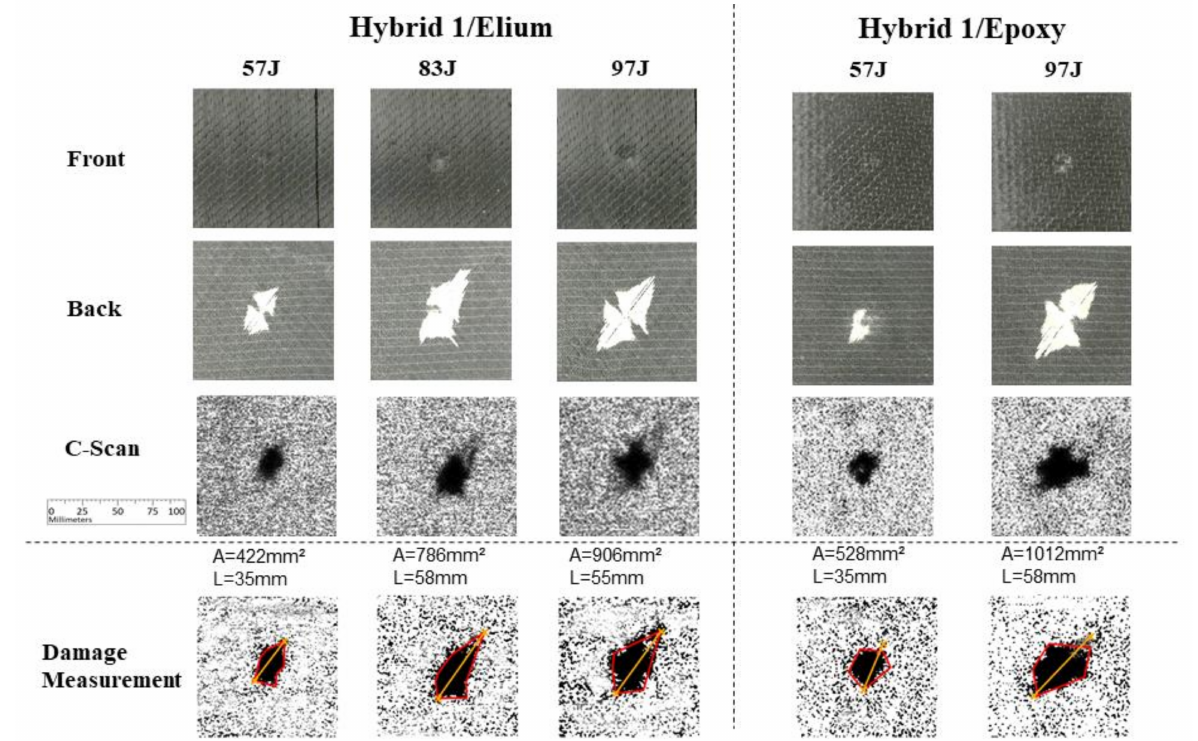
Figure 15. Experimental results for Hybrid 1 carbon/glass fibers specimens.